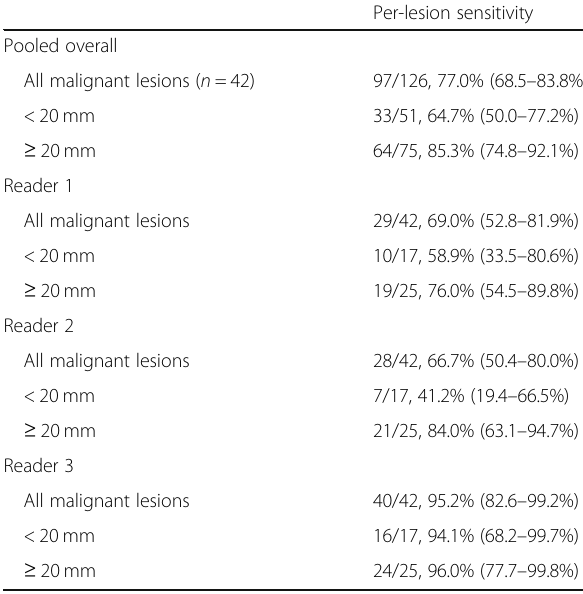
Table 4 Per-lesion sensitivity for aNC-MRI for LI-RADS 4, 5 and M categories full protocol including contrast-enhanced sequences